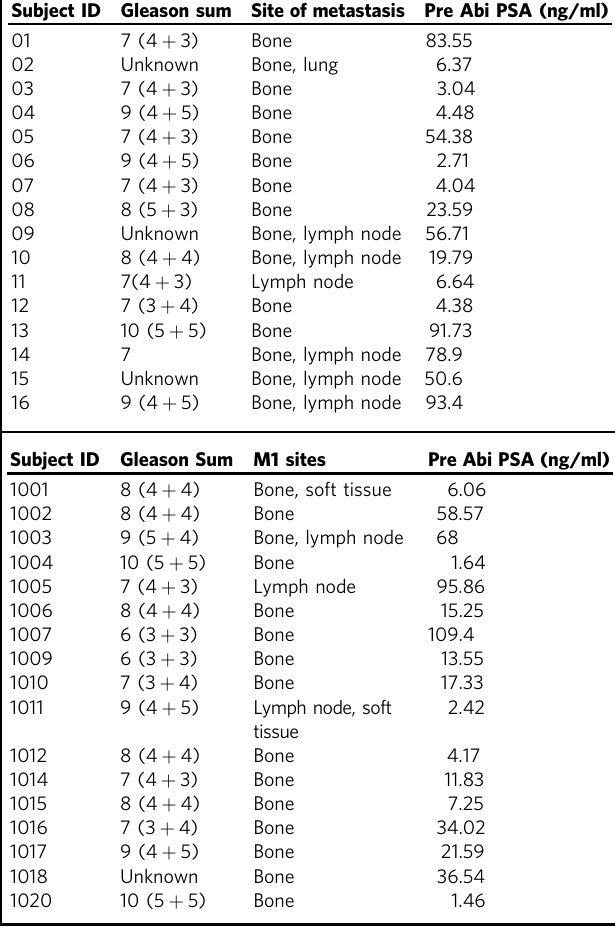
Table 2 Information on each patient within both